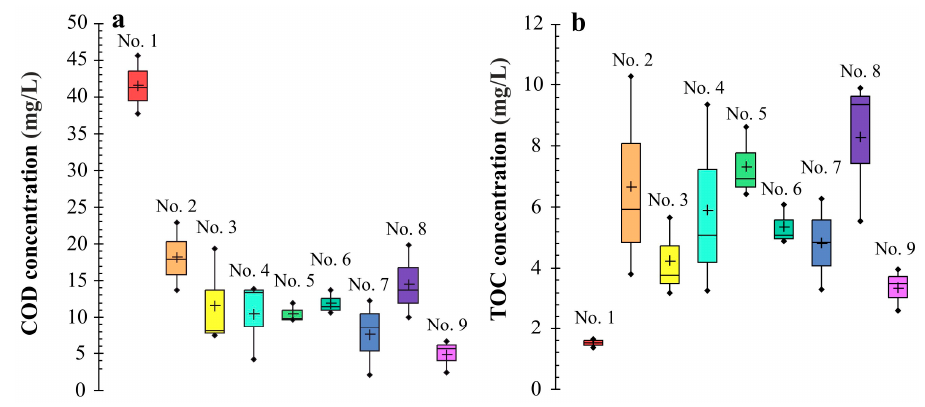
Figure 7. Boxplots showing the median, quartiles, and minimum and maximum values of quality parameters of samples: ( a ) COD; ( b ) TOC.